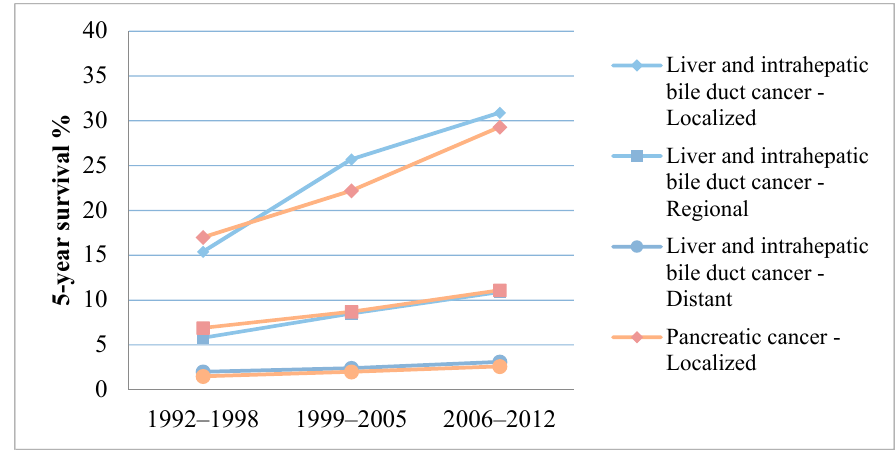
Figure 1. Five-year survival rates for hepatobiliary and pancreatic (HBP) cancers by stage from 1992 to 2012 [7,63,64].